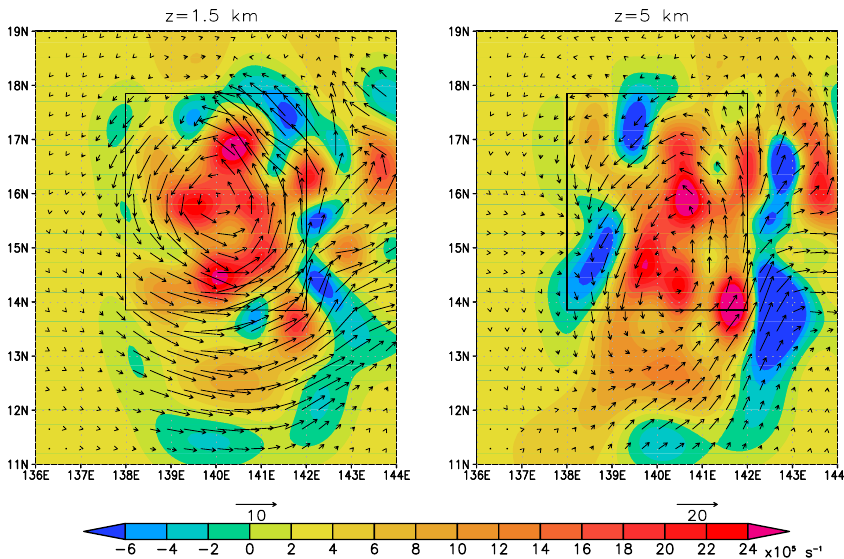
Figure 8. Two-panel plot of absolute vorticity (shaded) and wind vectors (co-moving) for Nuri 2 at 1.5km (left) and 5km (right) height from the 10km SAMURAI analyses. The black box is the four-degree length box centered on the 25km analysis 1.5km altitude sweet spot position and is for reference only. The abscissa is longitude and the ordinate is latitude.